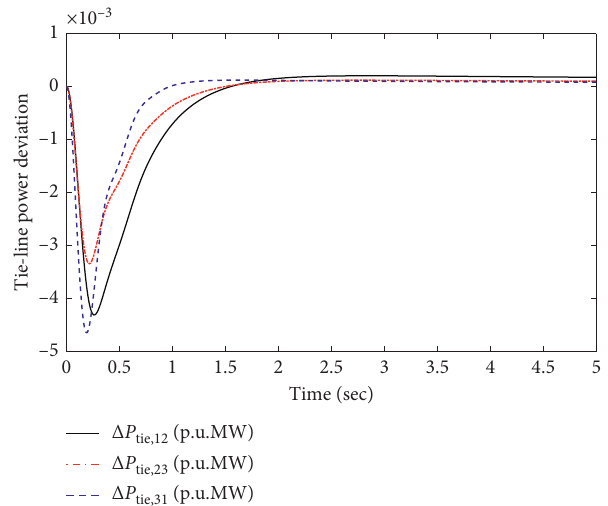
Figure 7: Tie-line deviation of the system under matched